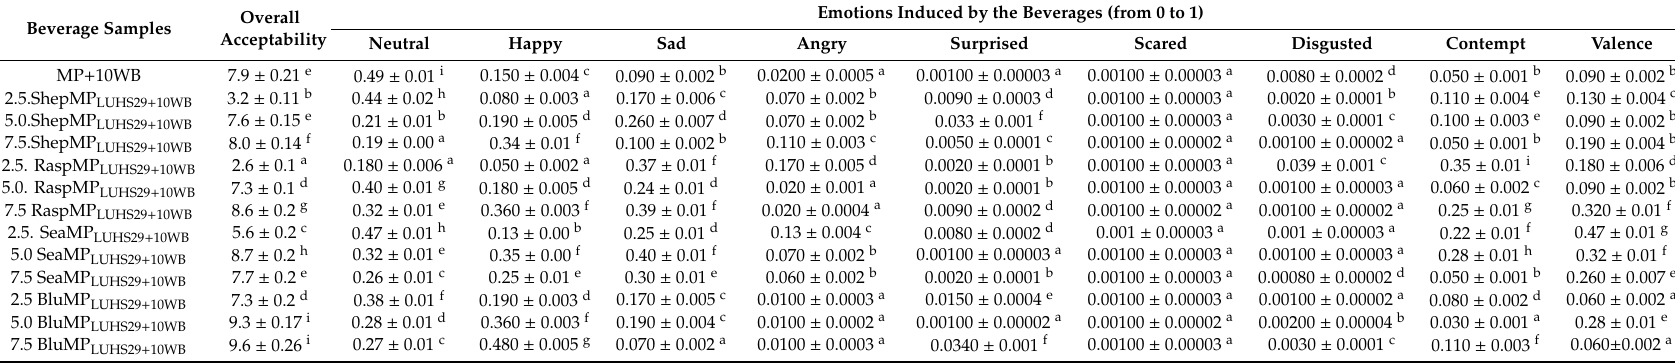
Table 7. Overall acceptability and emotions induced for consumers by the prepared beverages enriched with extruded and fermented wheat bran and fruit / berry